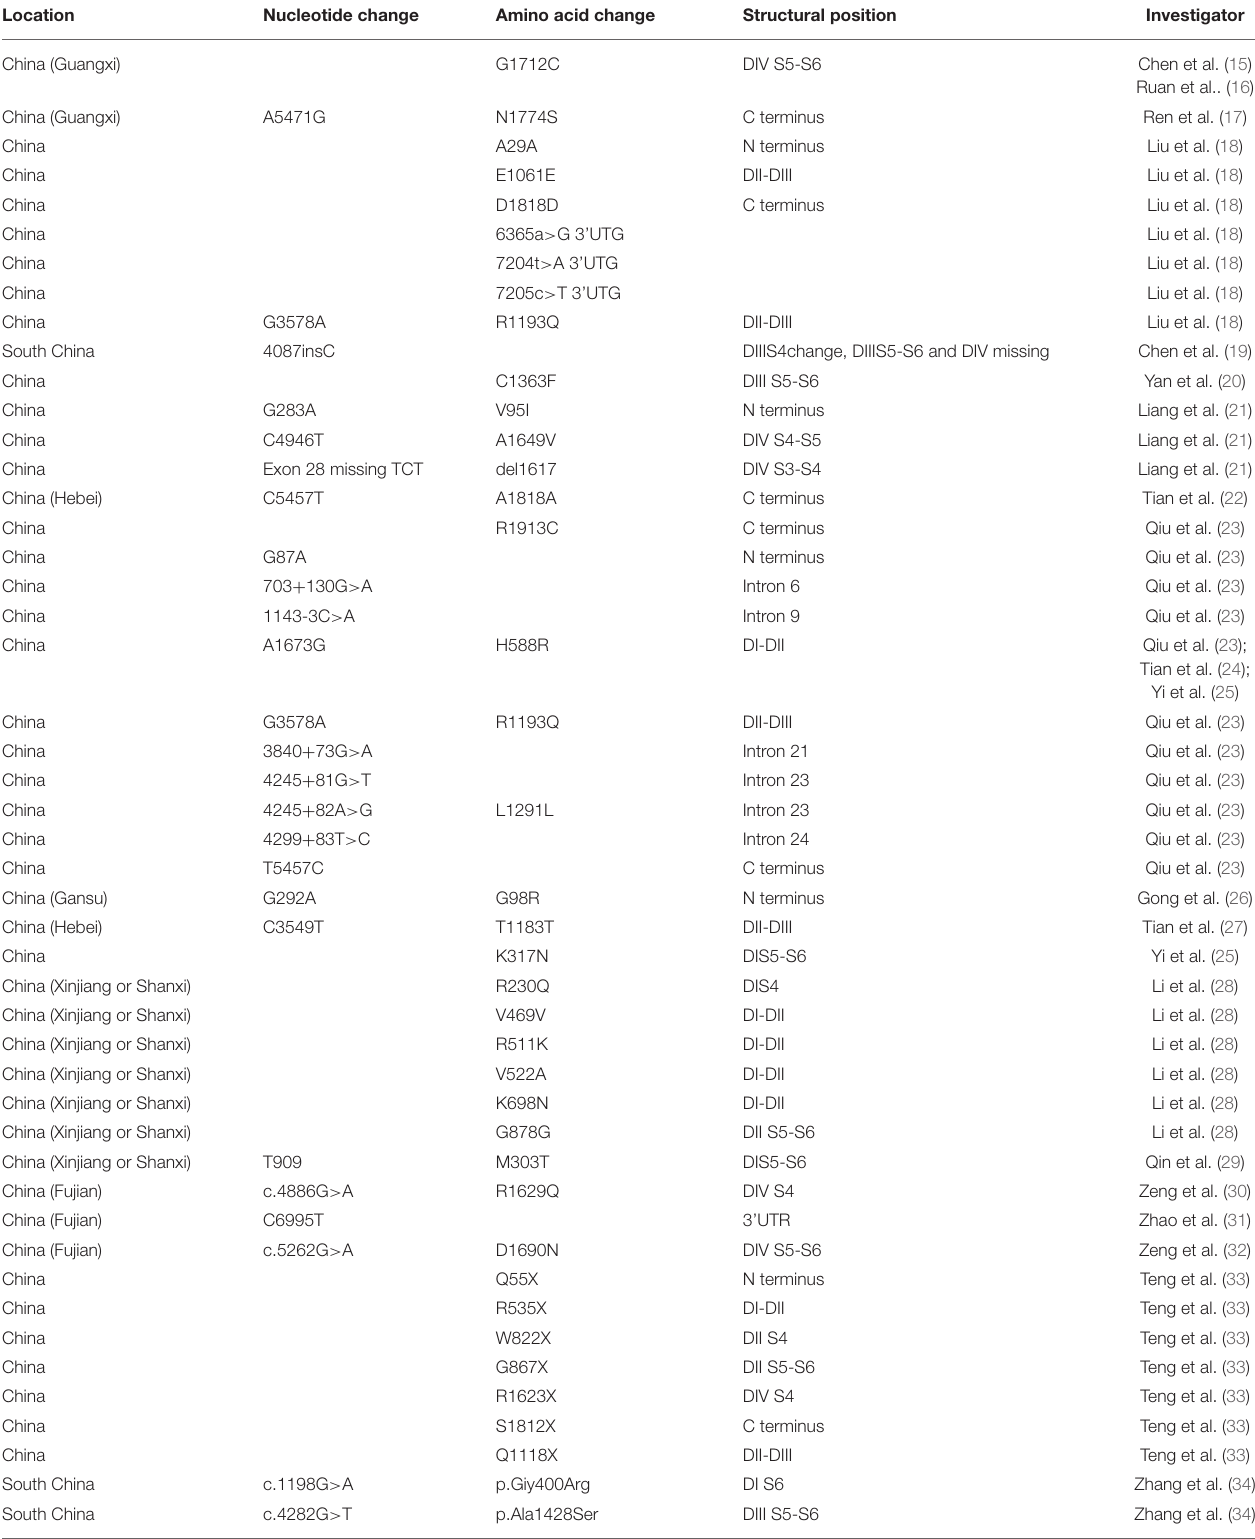
TABLE 1 | Distribution characteristics of SCN5A gene mutation/variation sites in Chinese BrS